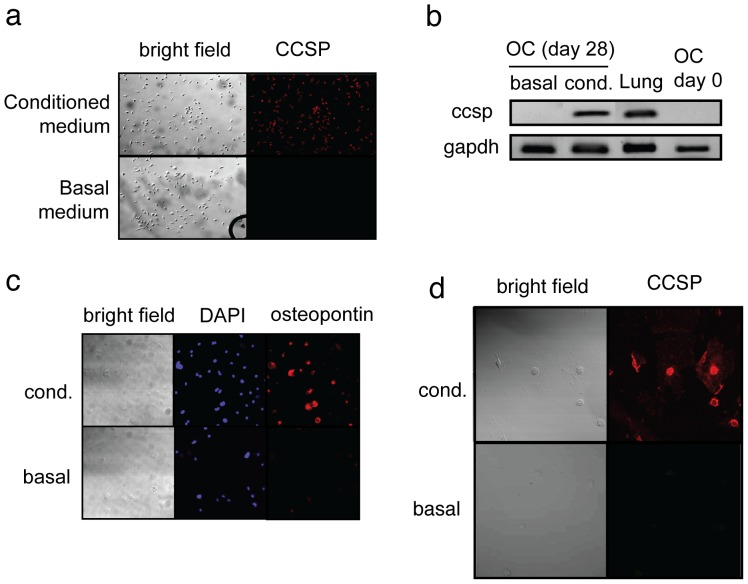
Differentiation of omentum cells into lung epithelium or osteoblasts.Omentum cells were cultured in the medium conditioned to induce (a, b, d) lung epithelium or (c) osteoblast. (a) After 5 weeks of culture, cells were stained for expression of CCSP. (×10) (b) Cells cultured as in (a) were used to determine the expression of ccsp mRNA by semi-quantitative RT-PCR. gapdh mRNA level was examined to determine the amount of mRNA in each sample. (c) Omentum cells cultured in the basal (lower panels) or medium conditioned for osteoblast induction (upper panels) for 2 weeks. Cells were stained by DAPI (middle) or with anti-osteopontin antibody. (d) Omentum cells were separated into CD45+, CD45−CD34+, or CD45−CD34− cells, and were cultured in the medium conditioned for lung epithelium cell induction. Only CD45−CD34+ cells survived and expanded to the analyzable level in the conditioned medium and are shown.